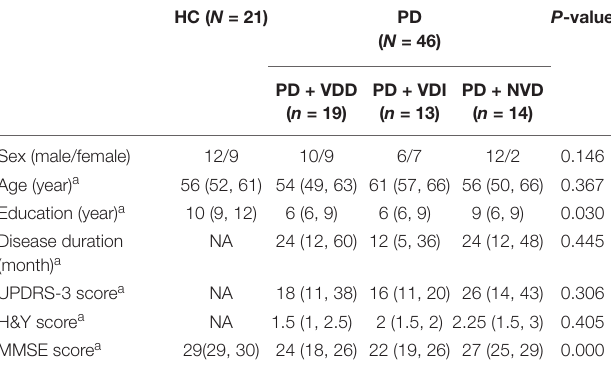
TABLE 4 | Demographic characteristics of the PD patients and health